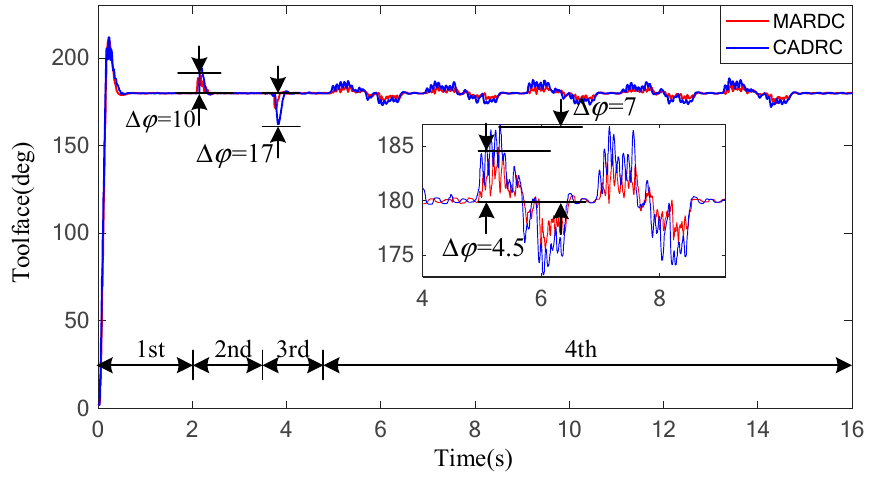
Figure 23. Toolface response curves. Energies 2019 , 12 , x FOR PEER REVIEW